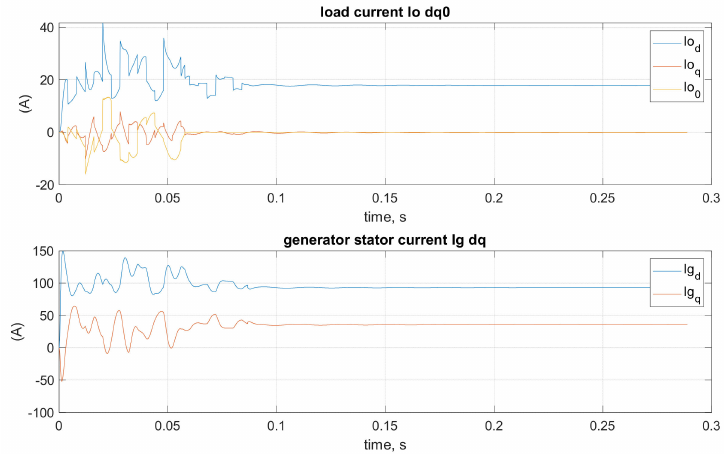
Figure 30. Oscillations of rotor current I r , generator current I g and generator voltage V g in dq coordinate